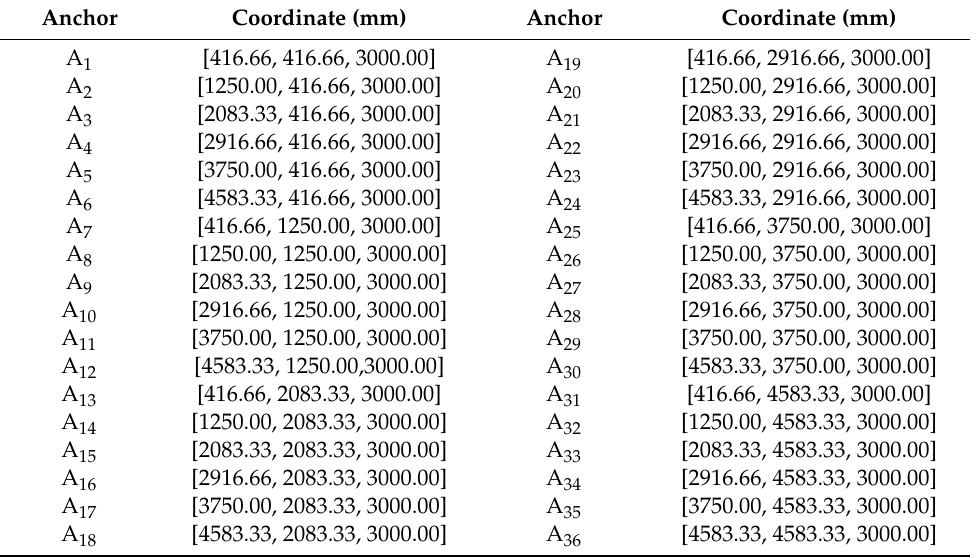
Table 2. The coordinates of anchors in ICS.